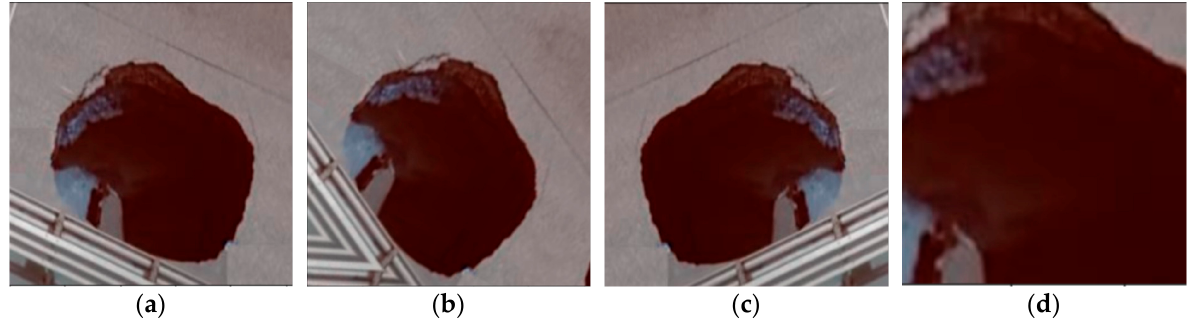
Figure 6. Applying data augmentation techniques to increase training data while training the autoencoder: ( a ) is the original image; ( b ) random rotation; ( c ) horizontal flipping; and ( d ) random cropping.